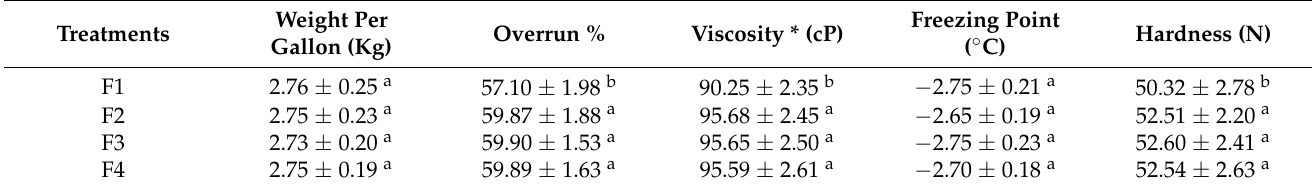
Table 4. Physical properties of probiotic-frozen yogurts with stevia, sucralose and sorbitol.